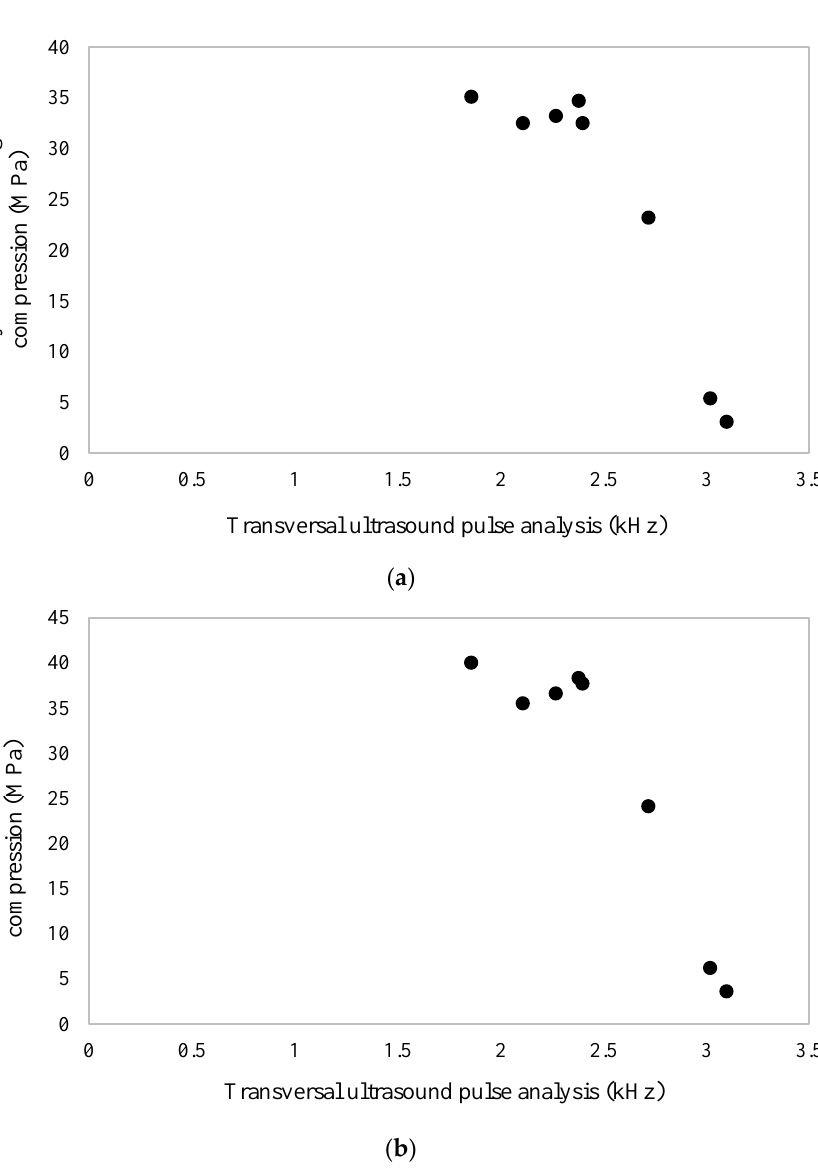
Table 4. Calibration equations for predicting unconfined strength of compression strength from transversal UPA.